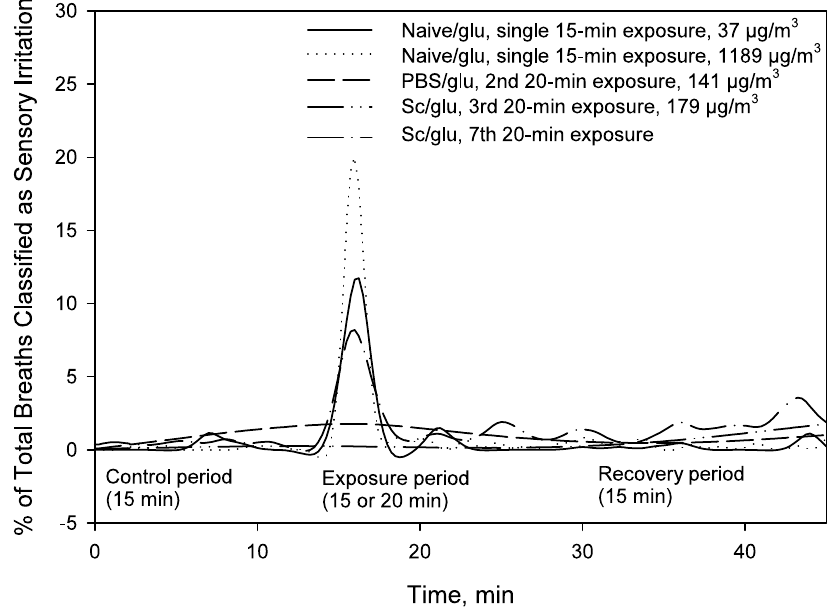
FIG. 2. Average time (cid:1) / response plots of breaths indicating sensory irritation (SI) upon inhalation exposure of four mice to b - glucan aerosol. Mouse group (immunization/inhalation exposure), the order of exposure, and exposure concentration are indicated. The naı¨ve/glu mice were male OF1 mice, and the rest of the groups consisted of female BALB/c mice. Diagnosis of SI requires an increase in time of braking greater than 2.0 times the stabdard deviation of the mean baseline value for that mouse. The time (cid:1) / response plots were prepared by plotting SI breath classification as a percentage of the total number of breaths collected during each 15 sec period. Unless three or more consecutive breaths were classified as SI, the program re- classified the breath as normal. This was done to reduce the number of abnormal breaths created by body movements 14 . Plots from the low and high single-exposure concentrations and from repeated exposures experiments are included. During the control and recovery periods, filtered air was fed into the breathing zone of the